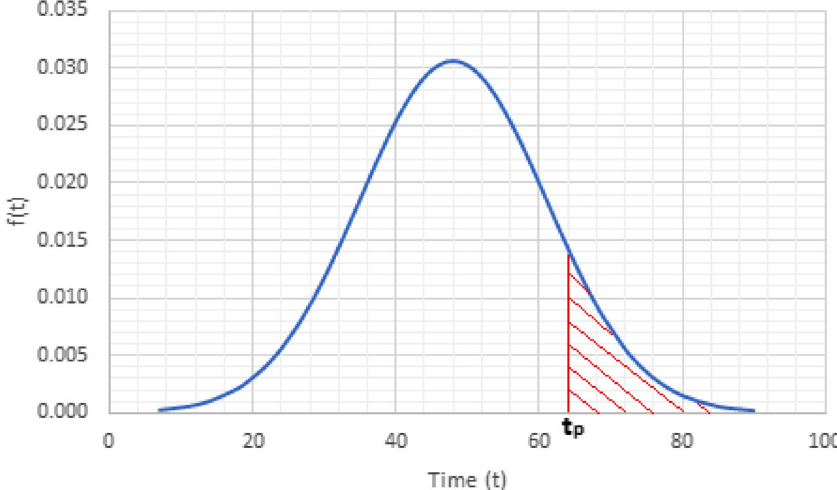
Fig. 1 Probability density